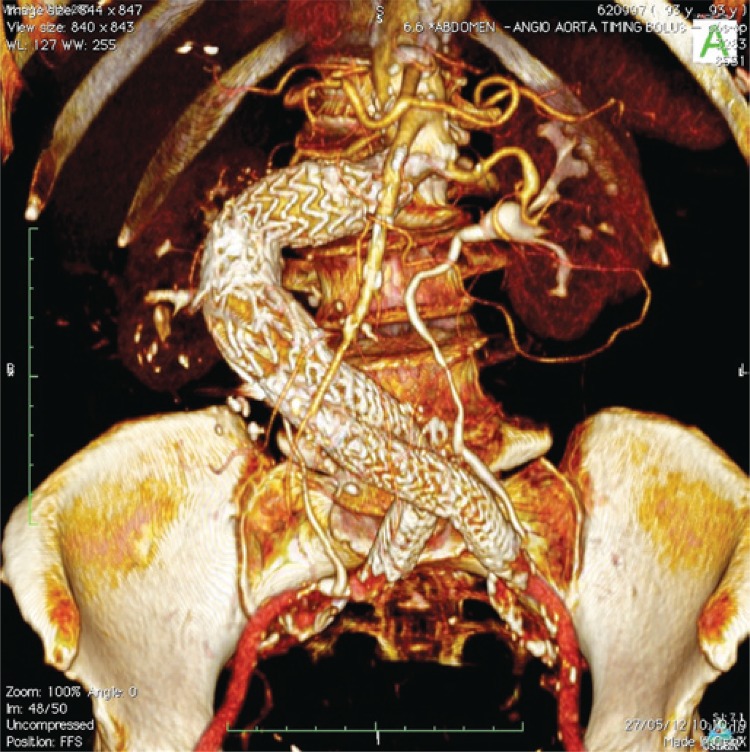
Controle tomográfico 1 ano após cirurgia, evidenciando bom posicionamento das endopróteses, sem extravasamentos